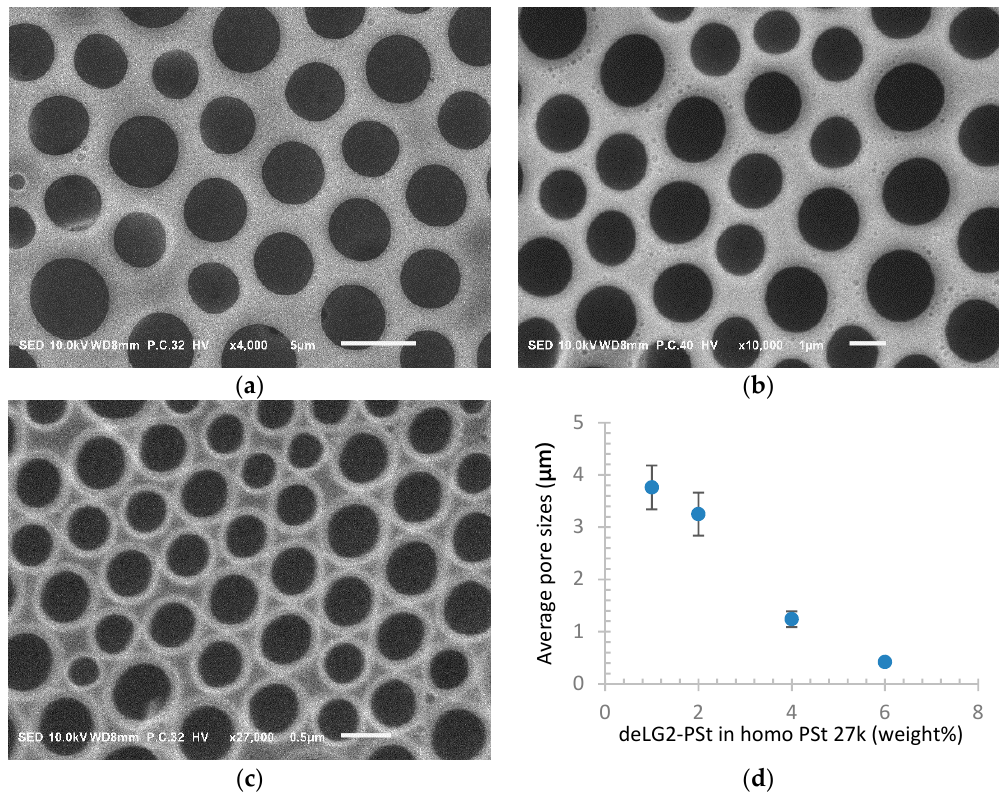
Figure 9. SEM images of BF films produced from deLG2-PSt 23k and homo PSt 27k at different LDBC concentrations: ( a ) 0.1 wt%, ( b ) 0.4 wt%, ( c ) 0.6 w t%. ( d ) Plot of average pore diameter vs. deLG2-PSt content.